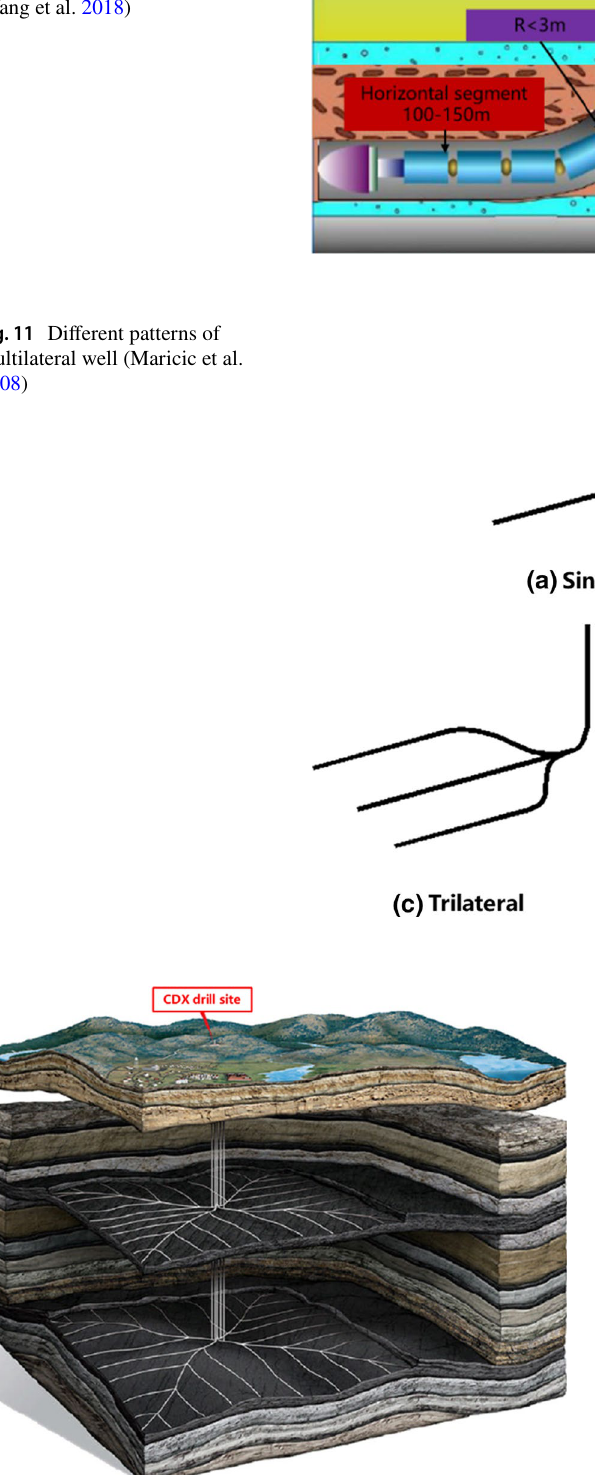
Fig. 10 Schematic of T-shaped horizontal well and flexible drilling tools, modified from (Yang et al. 2018)